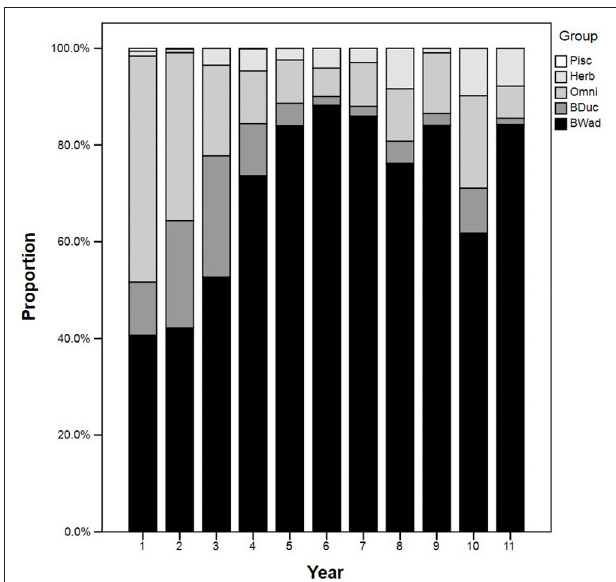
FIGURE 4 | Temporal guild composition (% abundance) of the foraging assemblage at the MR site. Guilds are abbreviated as follows: BWad, benthivorous waders; BDuc, benthivorous ducks; Herb, herbivorous ducks, geese, and swans; Omni, omnivorous ducks and rails; Pisc, piscivorous grebes, cormorant, and